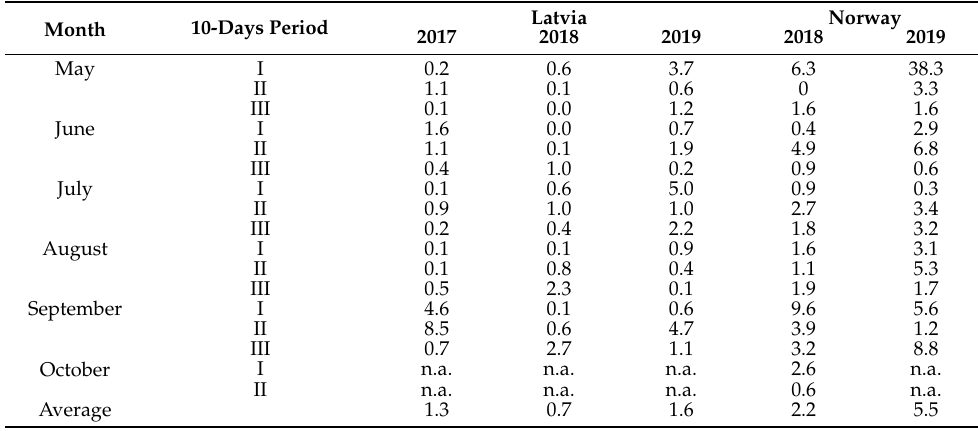
Table 3. Hydrothermal conditions during the trial period in both trial locations.